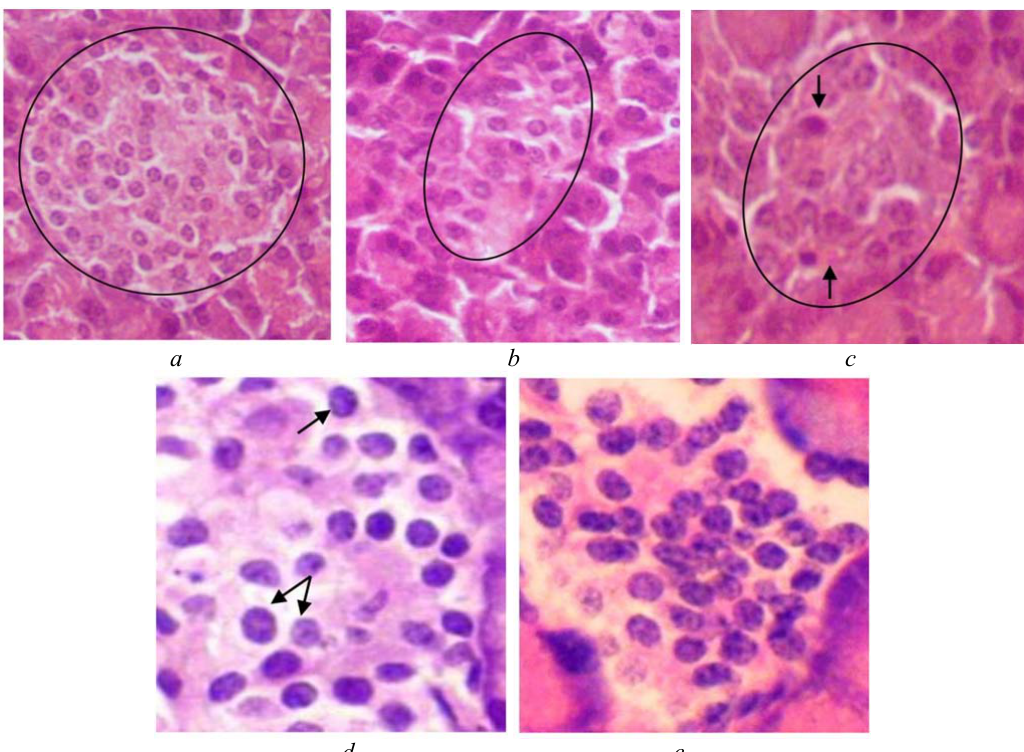
Fig. 2. The pancreas of Syrian hamster who received a diet rich in fats and fructose: a, b – the dilution of cells in pan- creatic islets, the practical absence of  -cells; c – destruction of  -cells in the islet; d – hypertrophy of the nucleus of  - cells; e – a certain "levelling" of the differential differences between the nuclei of the endocrinocytes; Hematoxylin- eosin; a–c – ×250; d, e –